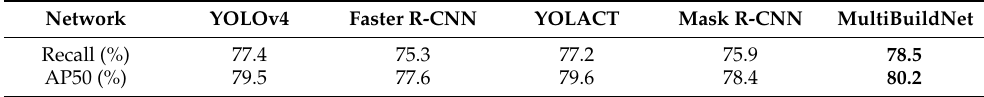
Table 3. Accuracy of building detection on the WHU dataset.